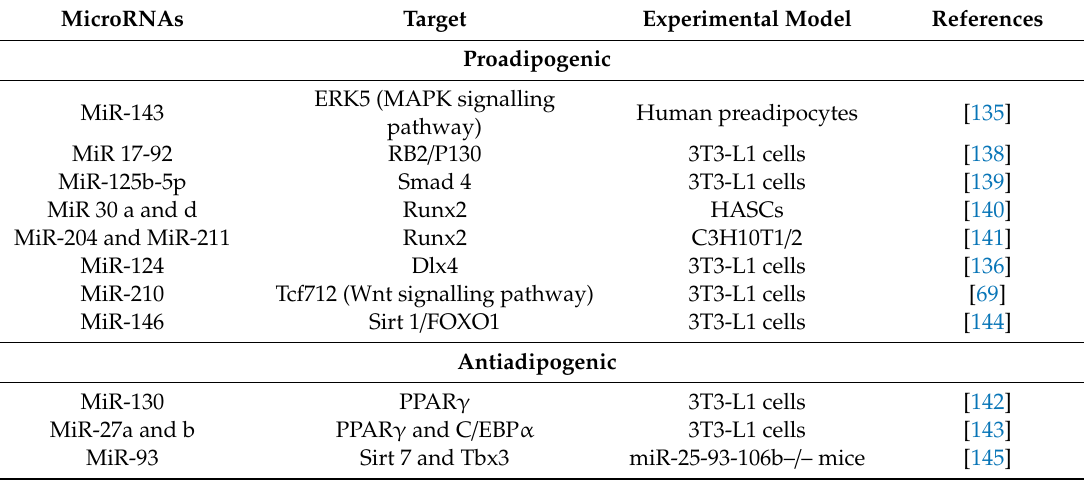
Table 3. MicroRNAs involved in the regulation of